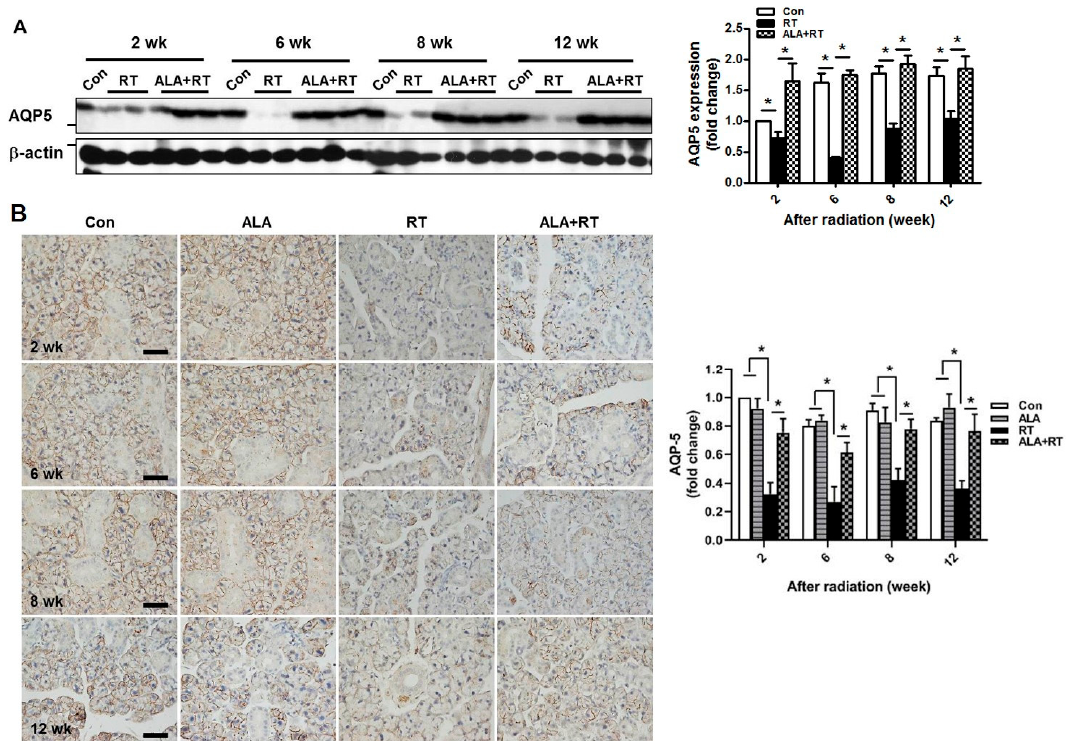
Figure 2. The administration of ALA improves radiation-induced AQP5 expression .